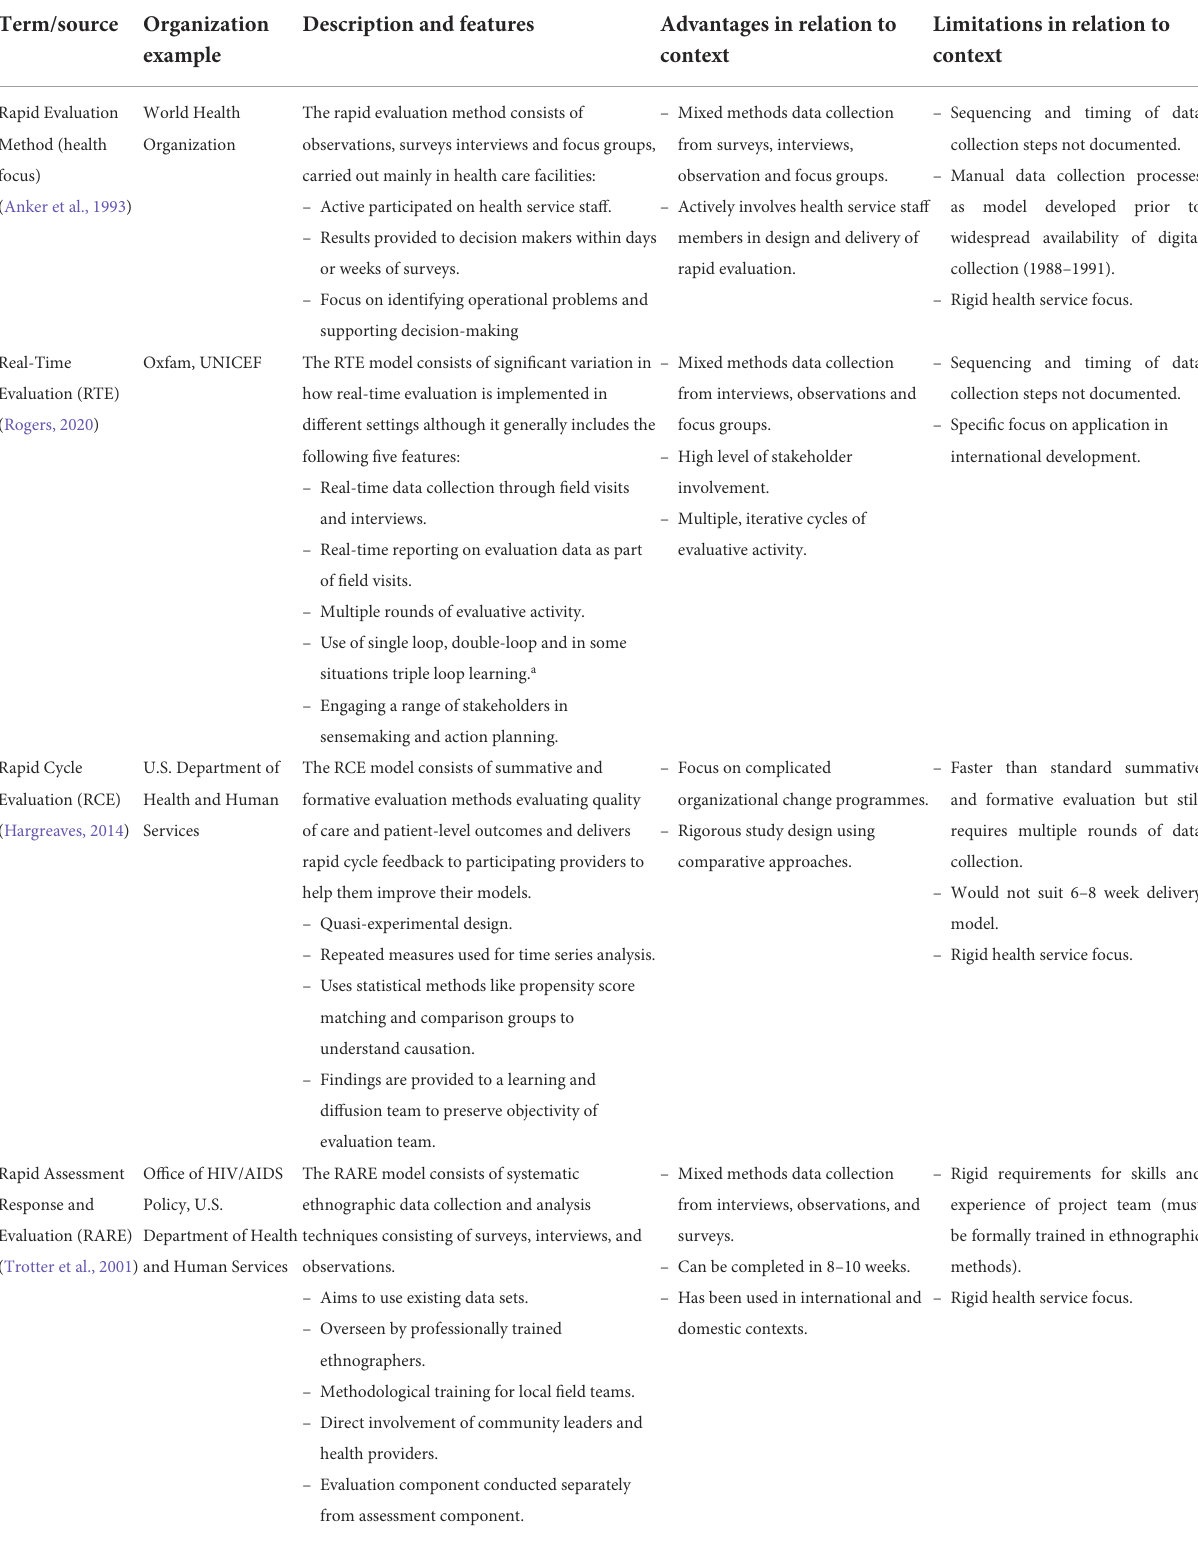
TABLE 1 Summary of features of rapid evaluation models and advantages and